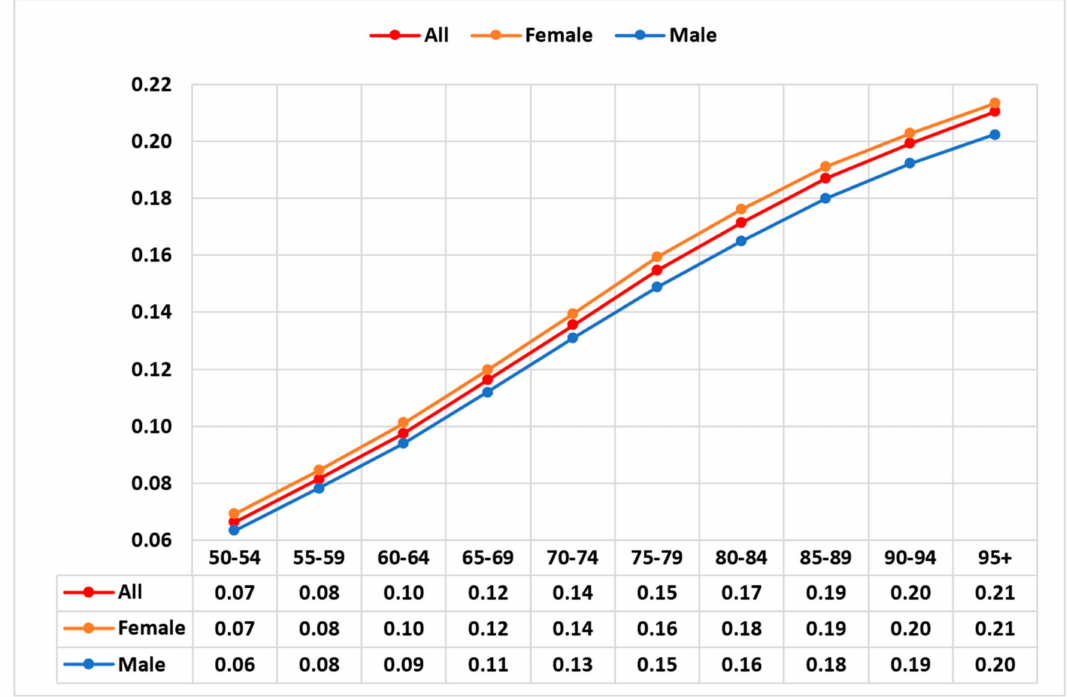
Figure 3. Mean Global Burden of Disease Frailty Index scores by age and sex for the global population of